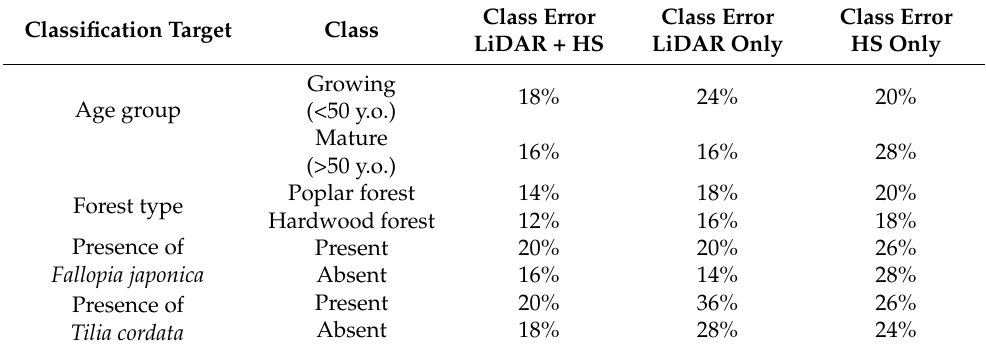
Table 7. Class error for each of the four random forest classifiers, according to the data used in the classifier–LiDAR and/or hyperspectral (HS). For each class, 50 plots were used to train the classifier.